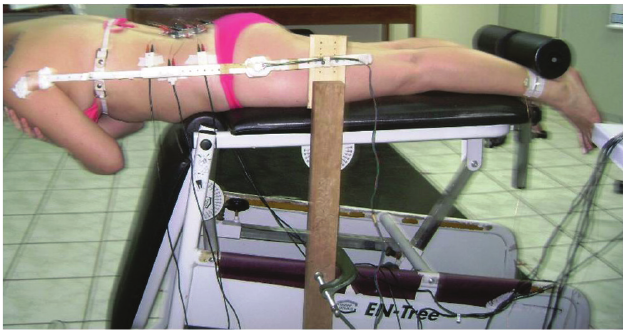
Figure 1. Sorensen test in lateral view, with ankles embedded in the roller support and arms crossed at chest